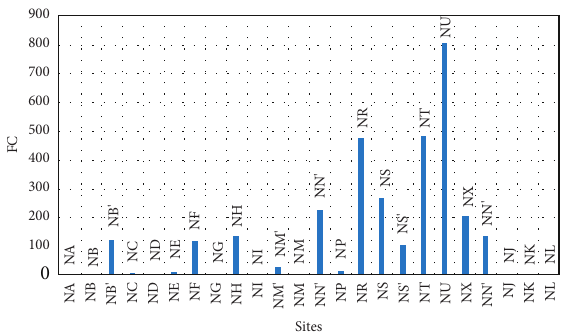
Figure 11: Average CF values for Lake Nokou´e sediments 2019–2020.